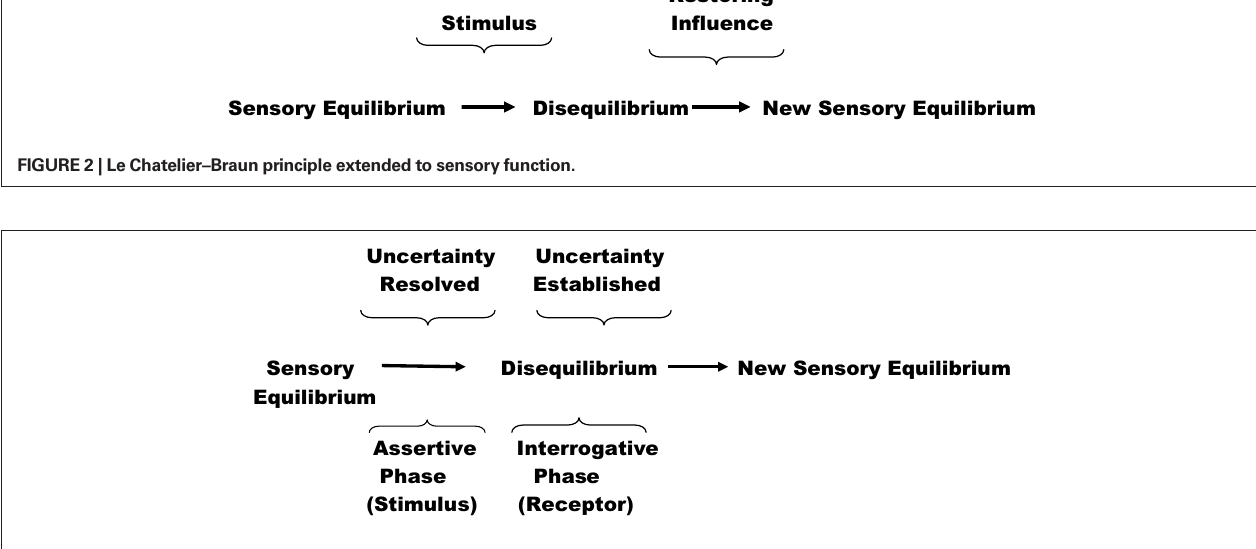
Figure 3 | evolution of Figure 2 to represent uncertainty set up by a receptor and resolved by receipt of a